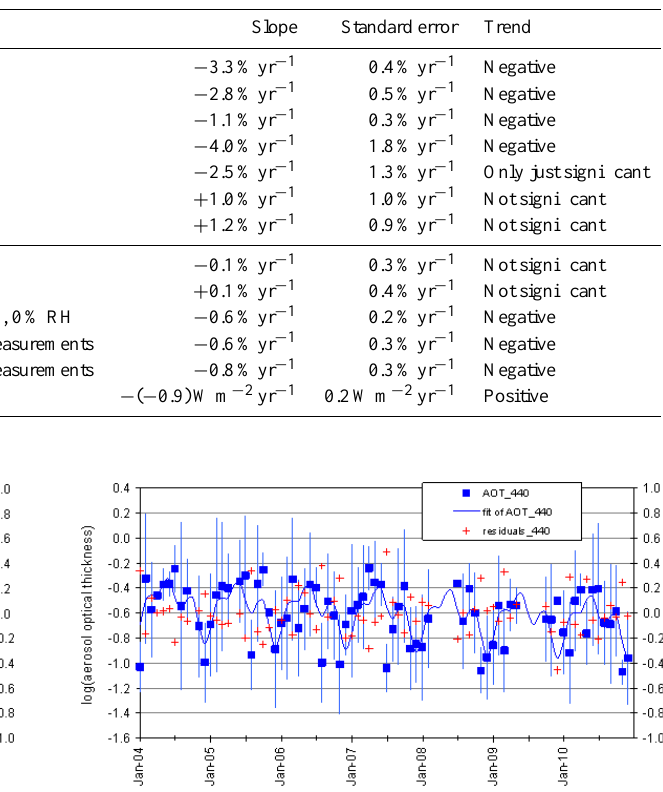
Table 1. Slope, standard error of the slope, and trends of variables observed at IPR, or calculated from observations performed at IPR (2004–2010).